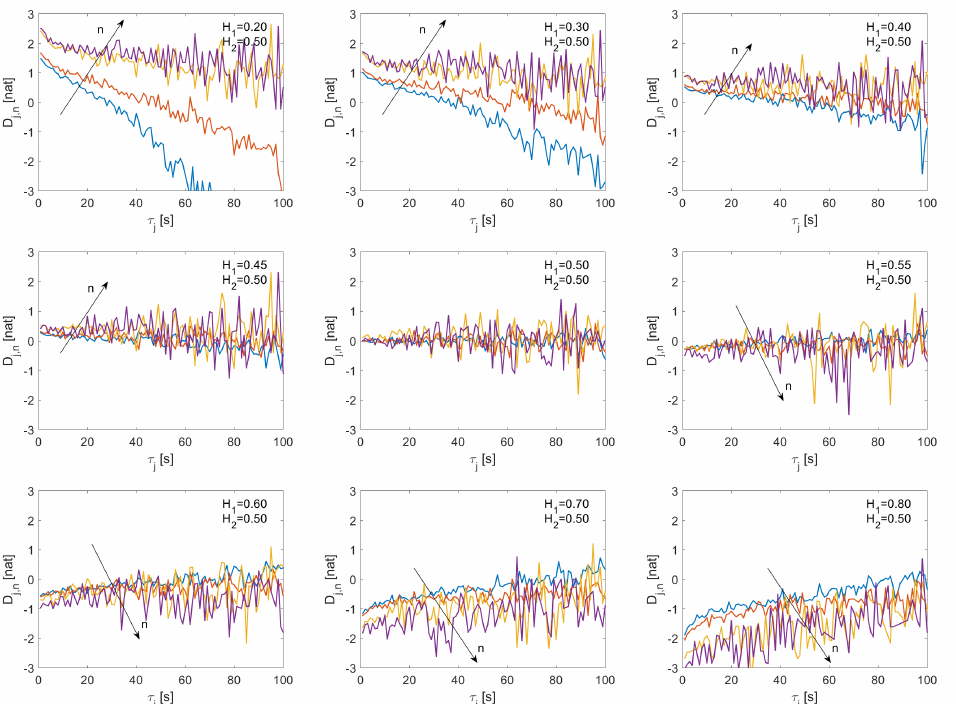
Figure 1: Plot of the quantity D , defined by Eq. (4), as a function of the cluster j , n duration τ for pairs of fBm with Hurst exponent H and H . The cluster frequency j 1 2 P ( τ , n ) is obtained by counting the occurrences of the clusters with duration τ j j in fractional Brownian motions with Hurst exponent H . A simple Brownian mo- 1 = 0.50, has been taken to obtain the cluster partition tion, i.e. a f Bm with H 2 and the model probability Q ( τ , n ) . In the above figures, H varies respectively j 1 from 0.20 (top-left) to 0.80 (bottom-right). The length of the series is equal to N = 500000 for all the graphs. Different curves in each graph refer to different n values ( n = 50,100,1000,2000) as indicated by the arrow. At large values of the = 0, expected at large τ parameter n , the curves tend to the asymptotic value D , j , n j whereas the curves exhibit a diverging behavior at small values of τ . Conversely, at j small values of the parameter n , the curves tend to the theoretical value expected at small values of τ , whereas the curves diverge at large τ . The properties of D are j j j , n discussed in Section 3 on the basis of the analytical expression derived for continuous random